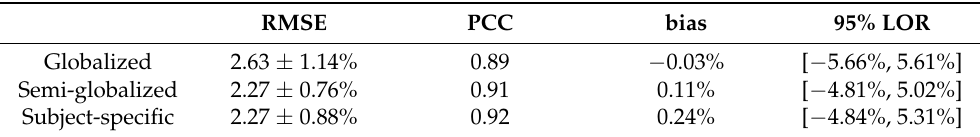
Table 2. Comparing the results of three training schemes based on their RMSE, PCC, bias, and 95%